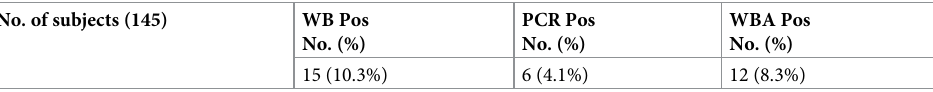
No; number, WB; Western Blot, PCR; Polymerase Chain Reaction, WBA; Whole blood assay, Pos;